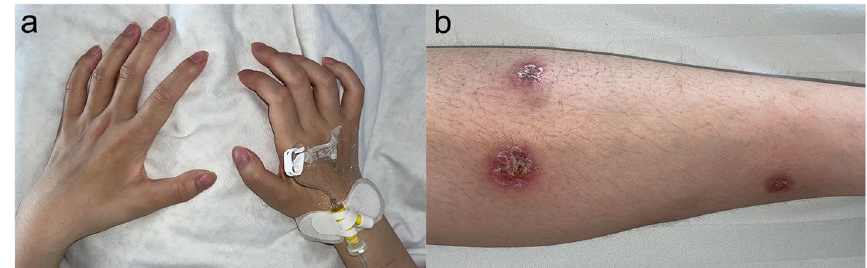
Fig. 1 a Muscle atrophy of both hands at admission b Rash on left leg at admission, crusted